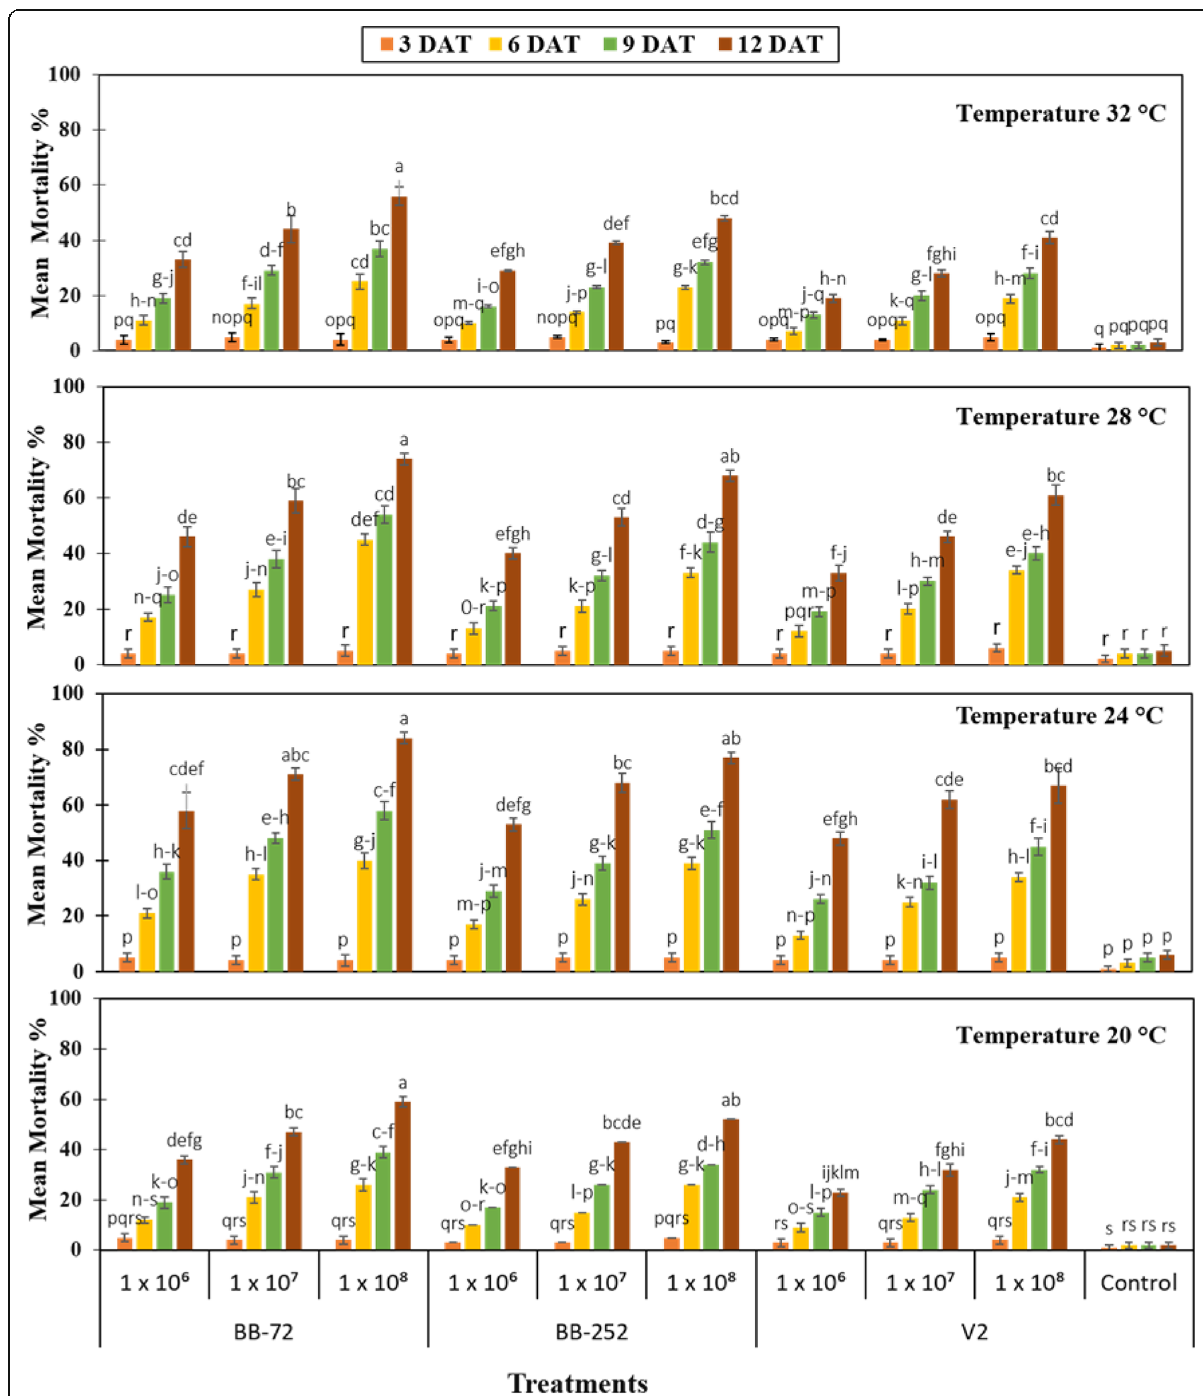
Fig. 1 Mean mortality percentage of Bemisia tabaci recorded at different temperatures, concentrations, and time intervals (DAT: days after treatment) for conidia bioassays carried out with two strains of Beauveria bassiana (BB-72 and BB-252) and one strain of Lecanicillium lecanii (V-2). Columns represent mean percent mortality ± SE ( n = 10). Treatment columns bearing different alphabets are significantly different from other treatments (least significant difference (LSD) test at α =